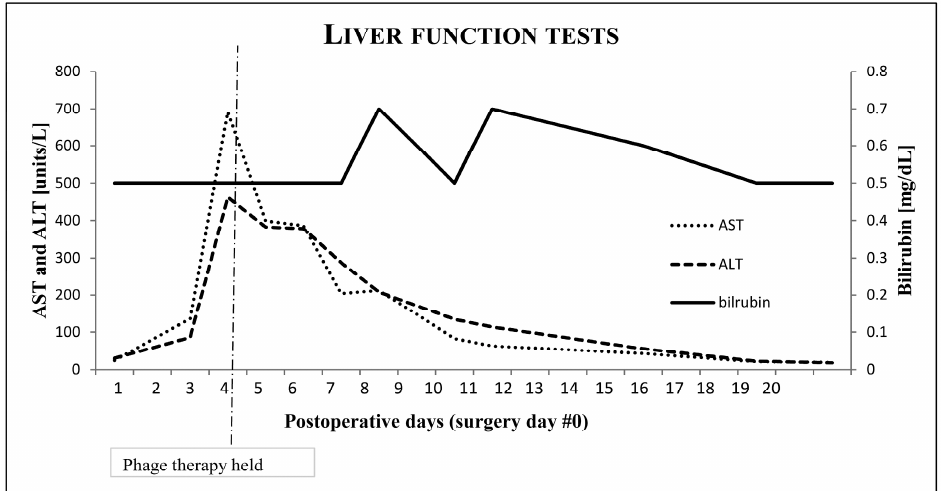
Figure 2. Graph of liver function tests over time of phage therapy.